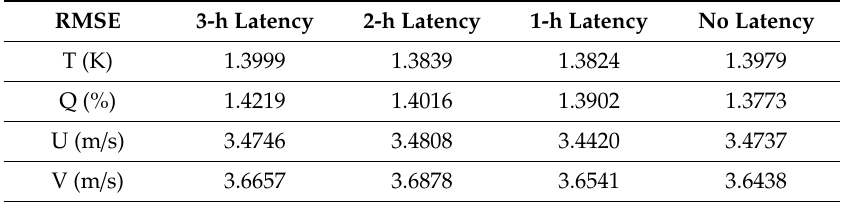
Table 3. The RMSE of the T / Q / U / V between the radiosonde profiles and the forecast fields of the four